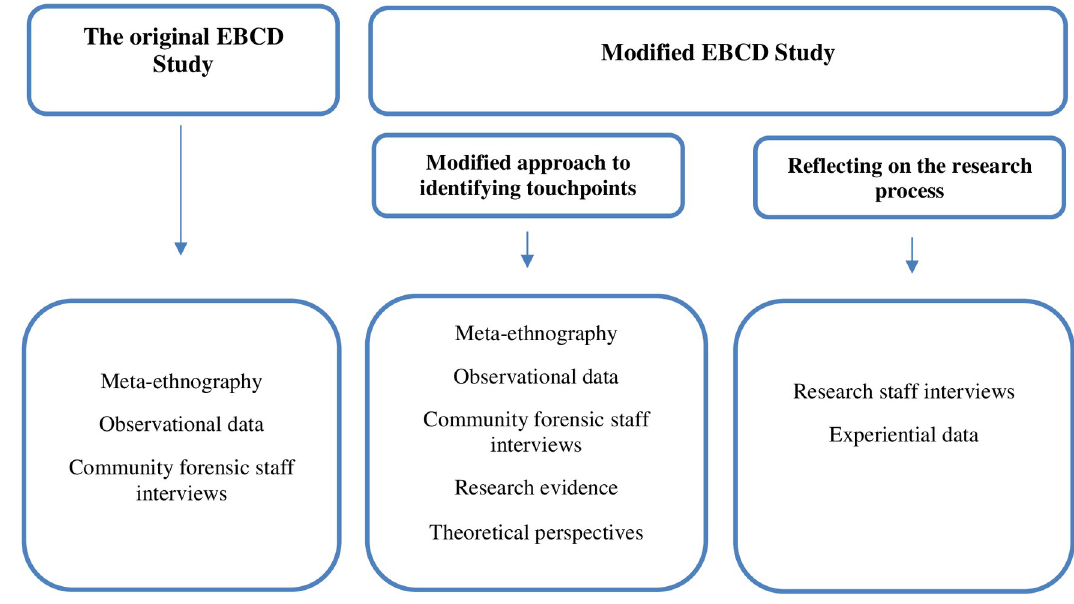
Fig 1. Proposed and modified study methods and data